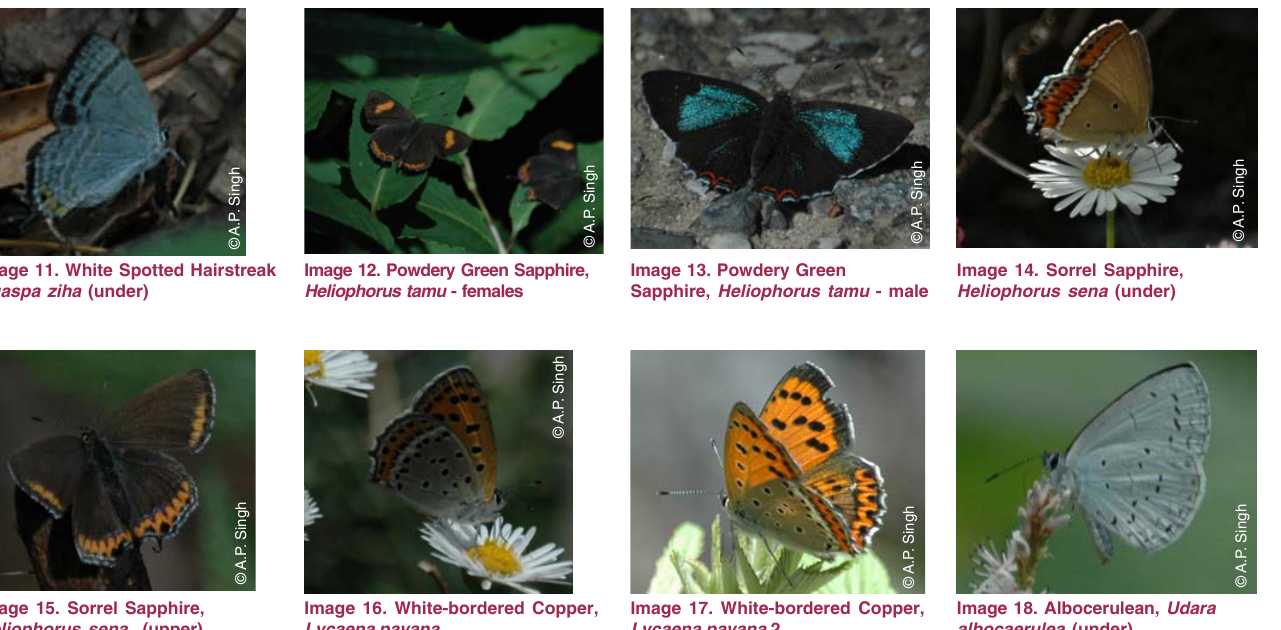
Image 18. Albocerulean, Udara albocaerulea